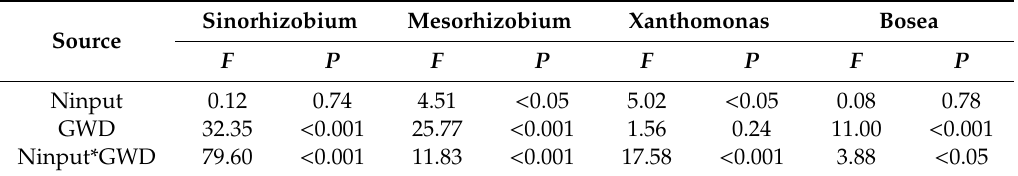
Table 2. E ff ects of depression of groundwater table, reduced nitrogen application and their interactions on the relative abundance of dominant genera in nir K-type denitrifier communities.